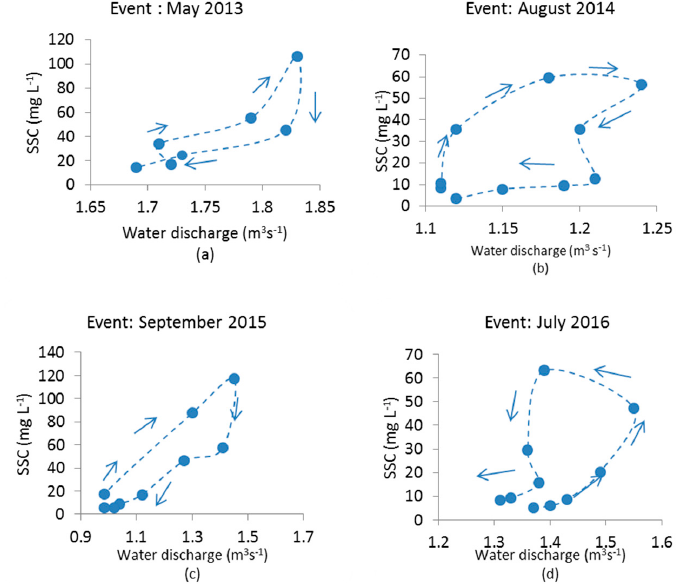
Figure 5. Typical hysteresis loops observed (daily averaged data) for summers of 2013 ( a ), 2014 ( b ), 2015 ( c ), and 2016 ( d ).